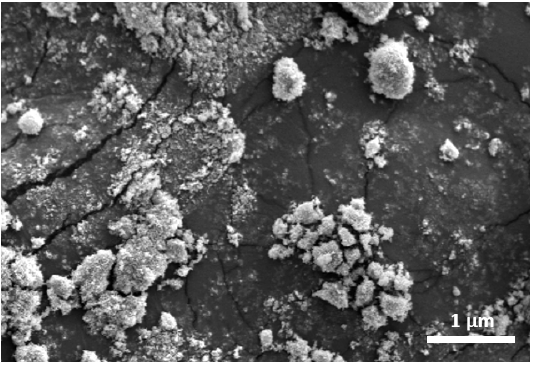
Figure 1. SEM images of TiO 2 nanoparticle synthesized by the hydrothermal method.